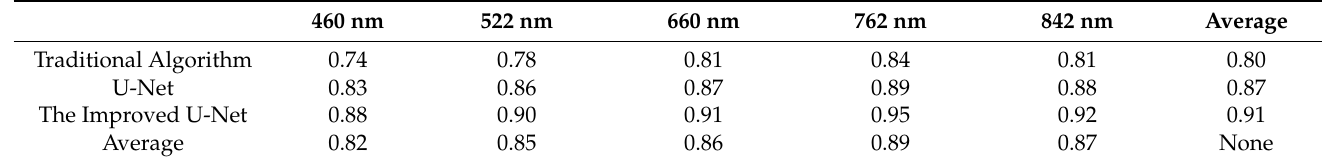
Table 3. mF1-score of the traditional algorithm, U-Net, and improved